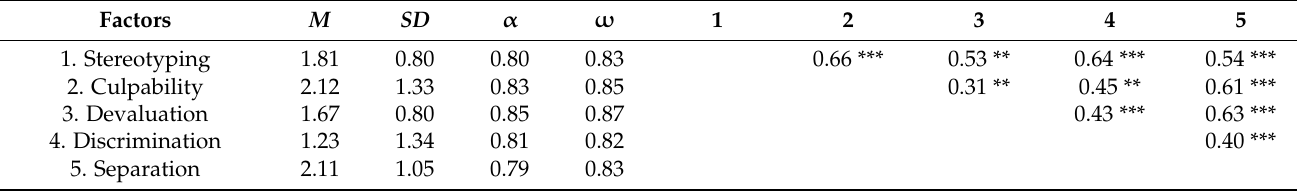
Table 2. Descriptive Statistics, Cronbach’s Alpha and Bivariate